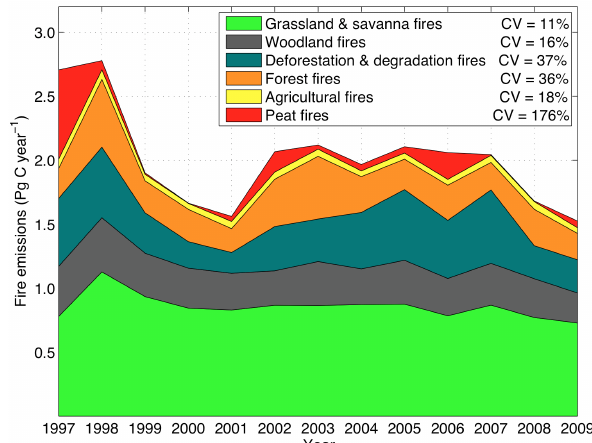
Fig. 8. Cumulative annual carbon emissions from different fire types and their coefficient of variation (CV) during 1997-2009.